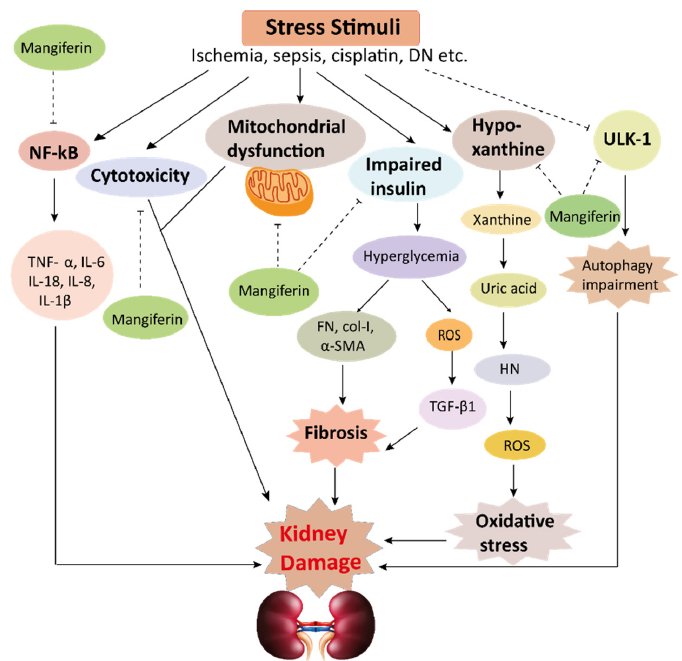
Figure 4. This schematic representation shows that stress stimuli example for, cisplatin, DN, Ischemia, and sepsis mediates various pathological conditions including cytotoxicity, oxidative stress, inflammation, fibrosis, autophagy dysfunction, and mitochondrial dysfunction. These ultimately lead to kidney damage. Stress stimuli activate the NF-kB signaling pathway which triggers the release of inflammatory cytokines (TNF- α , IL-6, IL-18, IL-8, and IL-1 β ) and decreases the action of ULK-1 thus autophagy impairment causes. Further col-1, FN, α -SMA causes accumulation of extracellular matrix (ECM) resulting in fibrosis. Mangiferin protects the kidney by suppressing the cascades of inflammatory pathways, oxidative stress, fibrosis, cytotoxicity, mitochondrial dysfunction, and autophagy impairment. ROS, reactive oxygen species; TNF- α , tumor necrosis factor- α ; IL-1 β , interleukin-1 β ; FN, fibronectin; α -SMA, α -smooth muscle actin; Col I, collagen I; TGF- β 1, transforming growth factor, ULK-51, unc-51-like kinase; DN, diabetic nephropathy; HN, hyperuricemic nephropathy; NF-kB, nuclear factor-kappa B.